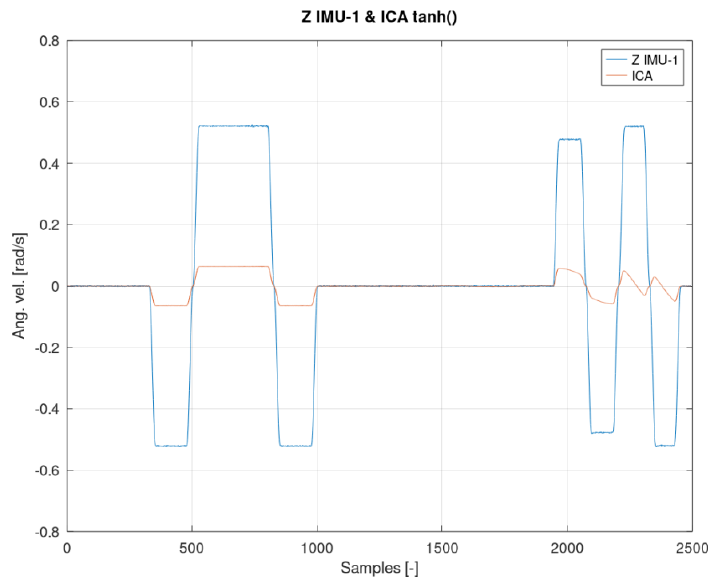
Figure 12. The result of the ICA algorithm on the basis of the activation Function (9).